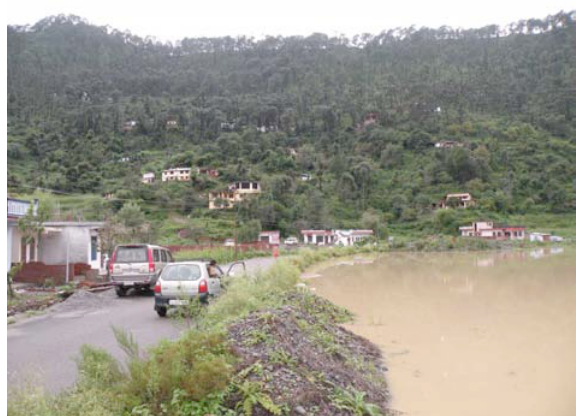
Image 3. Looking west over Bhimtal Lake, showing ongoing urbanization on Jones Estate watershed in January 2012. Image 4. Kuatal catchment in the background, showing degraded broadleaf forest when Kuatal filled for the first time in living memory July